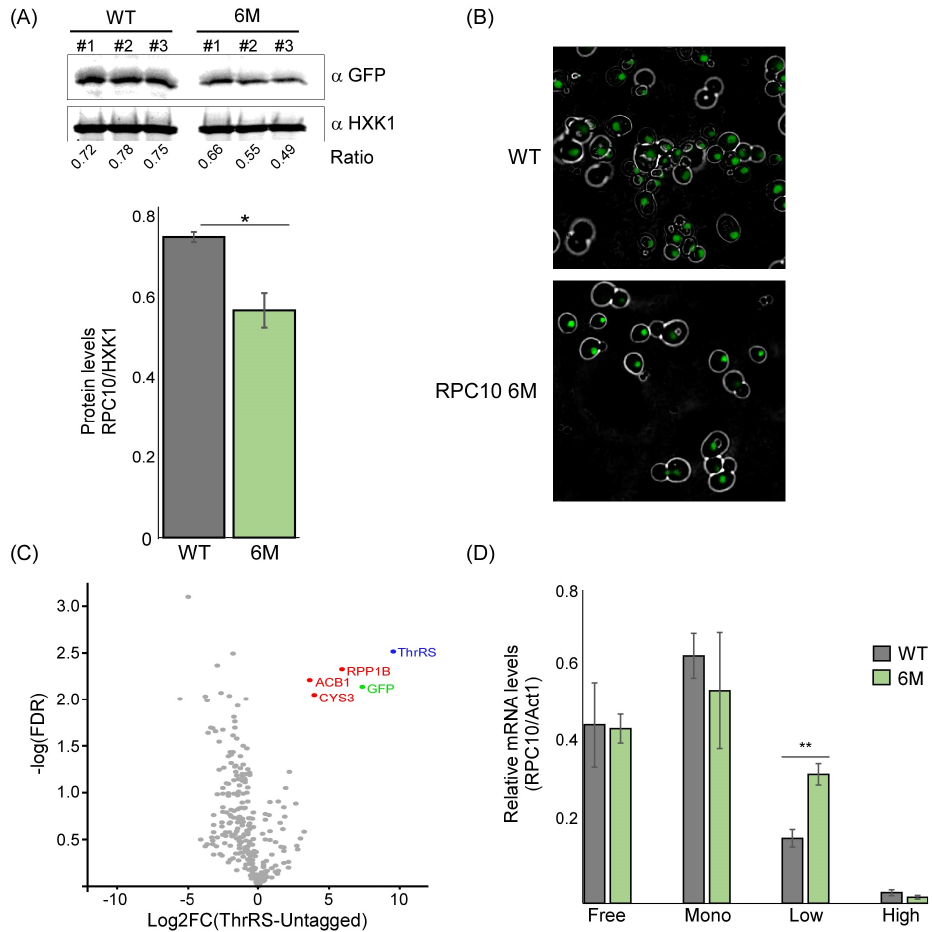
Figure 4. ThrRS impact on RPC10 expression. ( A ) Western analysis for RPC10 ‐ GFP expressed either from the normal transcript or the 6M mutant. The ratio is the quantification ratio between the ThrRS ‐ GFP and Hxk1 signals of three independent biological repeats. Histogram presents the quantifica ‐ tion average, error bars are SEM, and P ‐ value was calculated by the dependent samples’ one ‐ tailed t ‐ test. * <0.05 ( B ) GFP localization of RPC10 expressed from WT or 6M mutant mRNA.